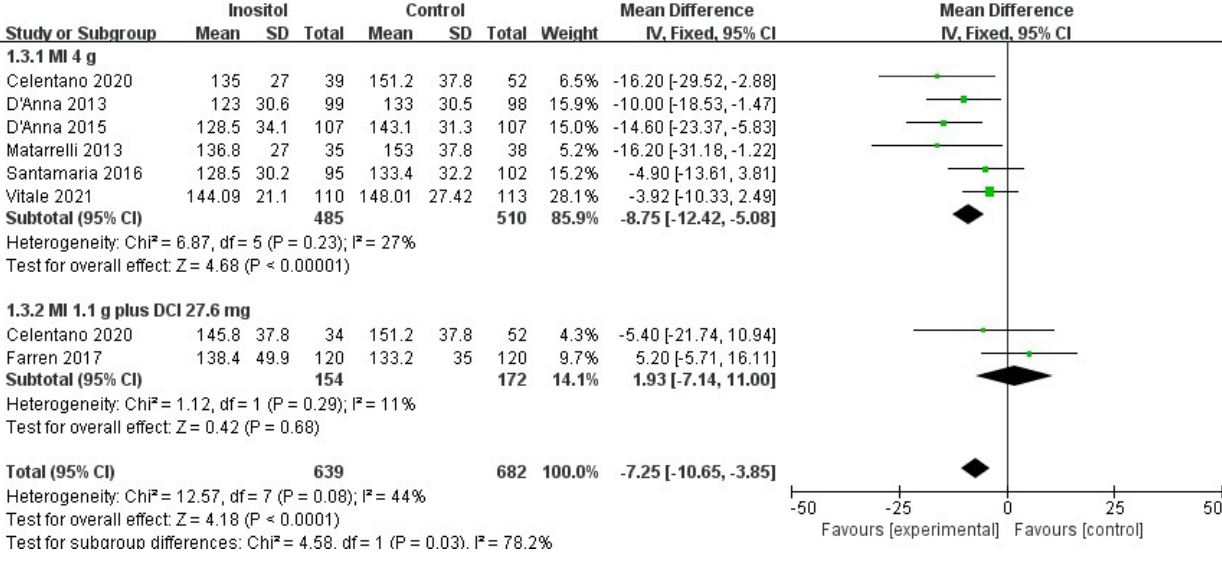
Figure 6. Inositol vs. control: 1-h OGTT [14–20].